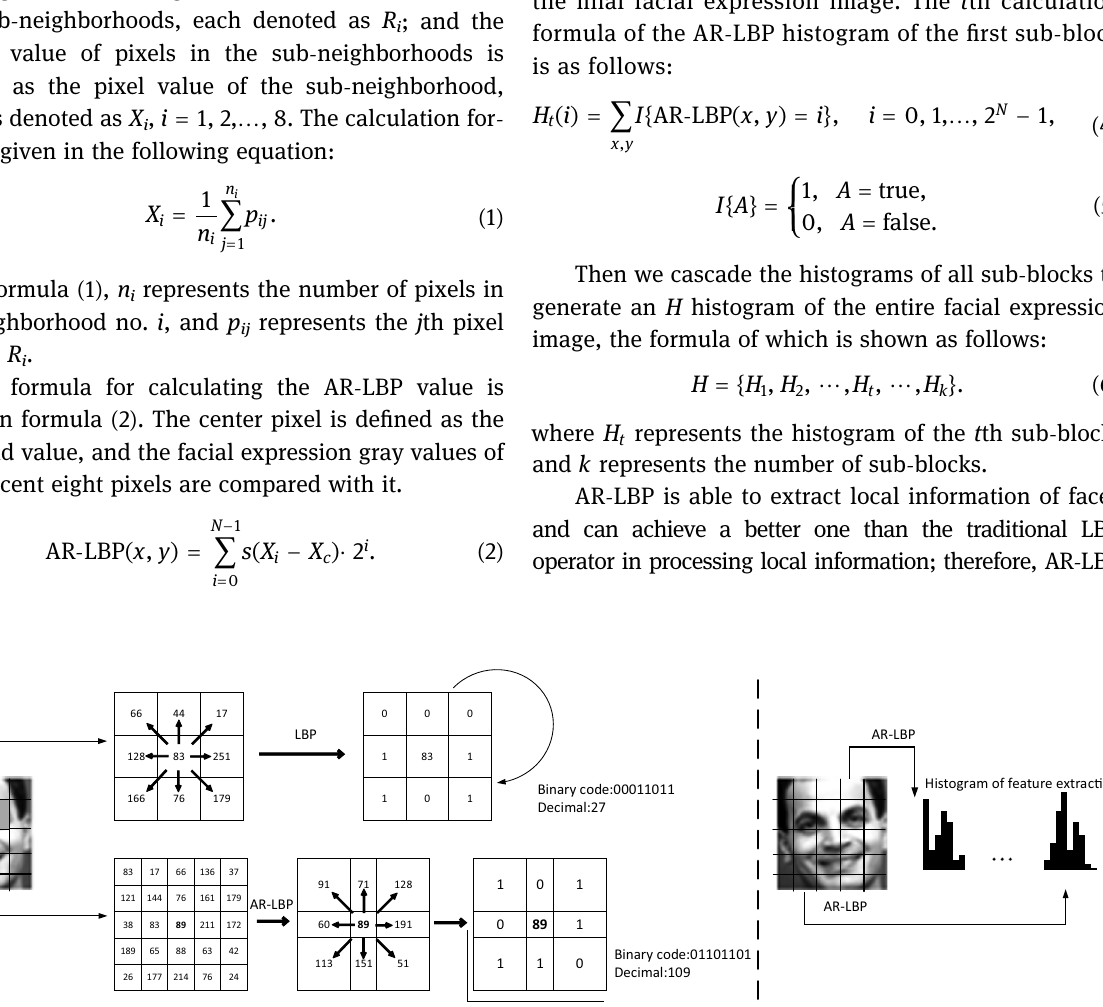
Figure 1: Feature extraction for LBP and AR -